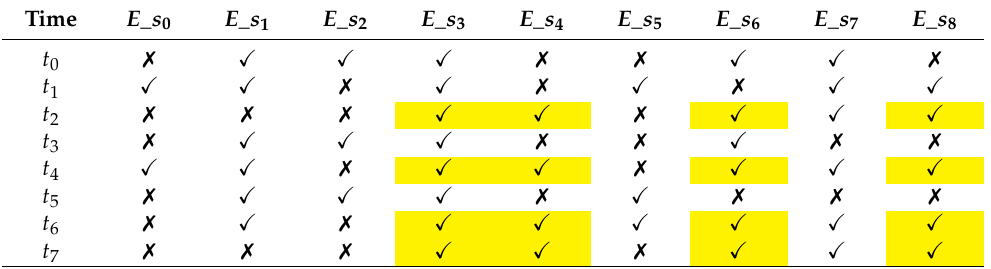
Table 1. Querying in archive A IoT with values of time and E returned by 9 ( N ) sensors. The yellow- colored cells represent valid measurements, which are returned as the result of the query.